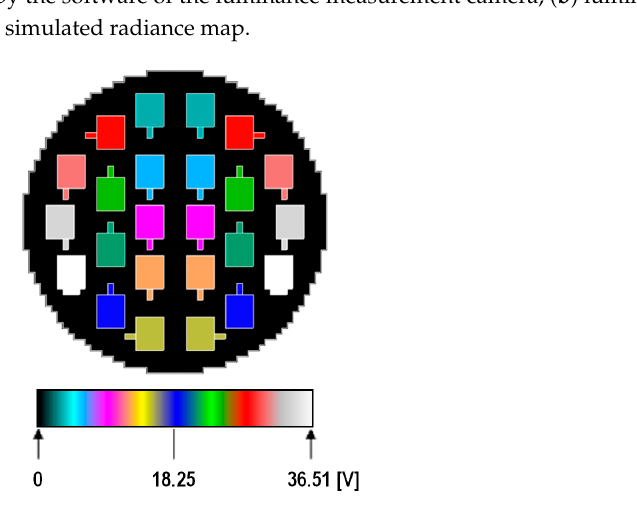
Figure 31. Simulated voltage distribution in the metallization layer of the anodes of the blue LED chips (400 mA driving current, 25 °C ambient temperature).